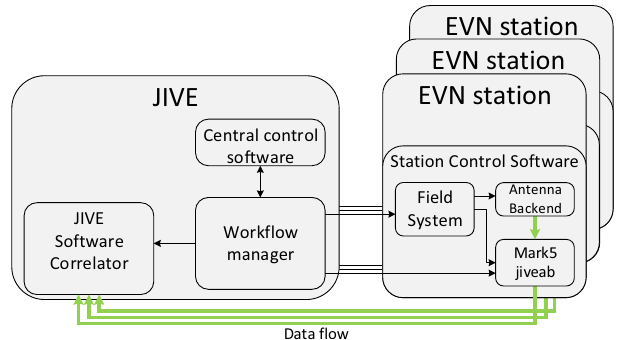
Fig. 2. The scheme of communication routes and the data flows in an e-VLBI session in EVN. Usually, 10 to 16 antennas take part in the e-VLBI sessions. Each